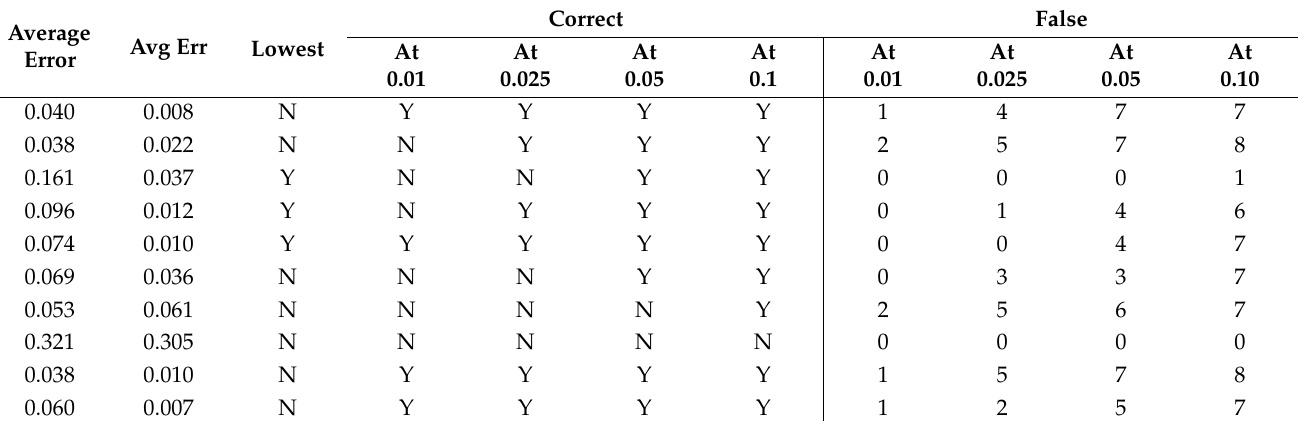
Table 4. Set 2, trials 1–10 summary data (average actual PR values).